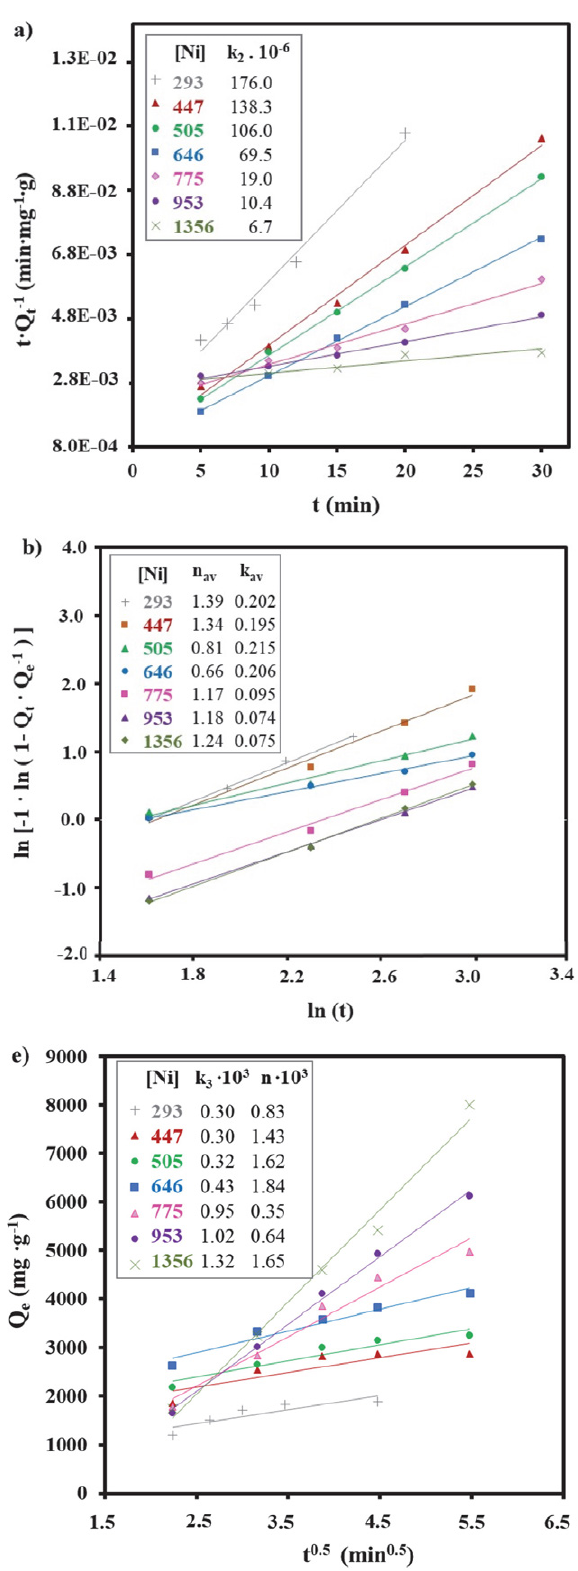
Figure 2. Adsorption of nickel with the electrode pair Al/Al at 9.8 mA cm –2 , 60 °C, pH 8.6, a) Pseudo-second order kinetic model, b) Avrami´s model, c) Elovich`s model, d) Bangham´s model, e) We- ber and Morris´s